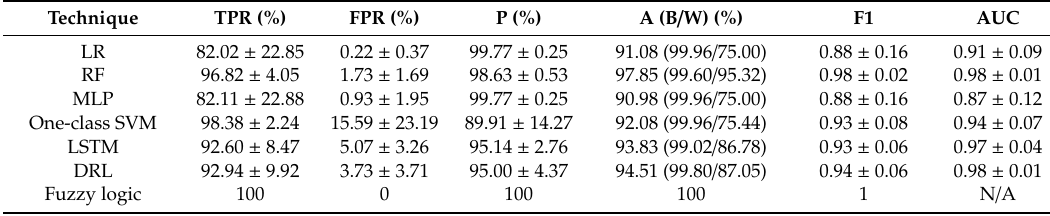
Table 7. Results for the machine learning